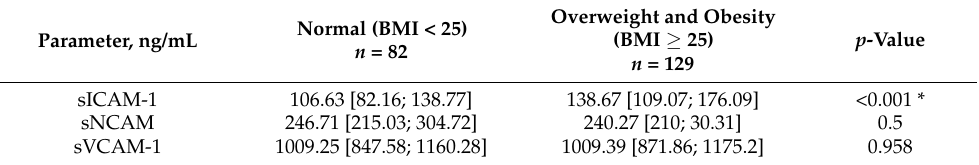
Table 3. Levels of CAMs in schizophrenia patients depending on their weight (Me [Q1; Q3]).